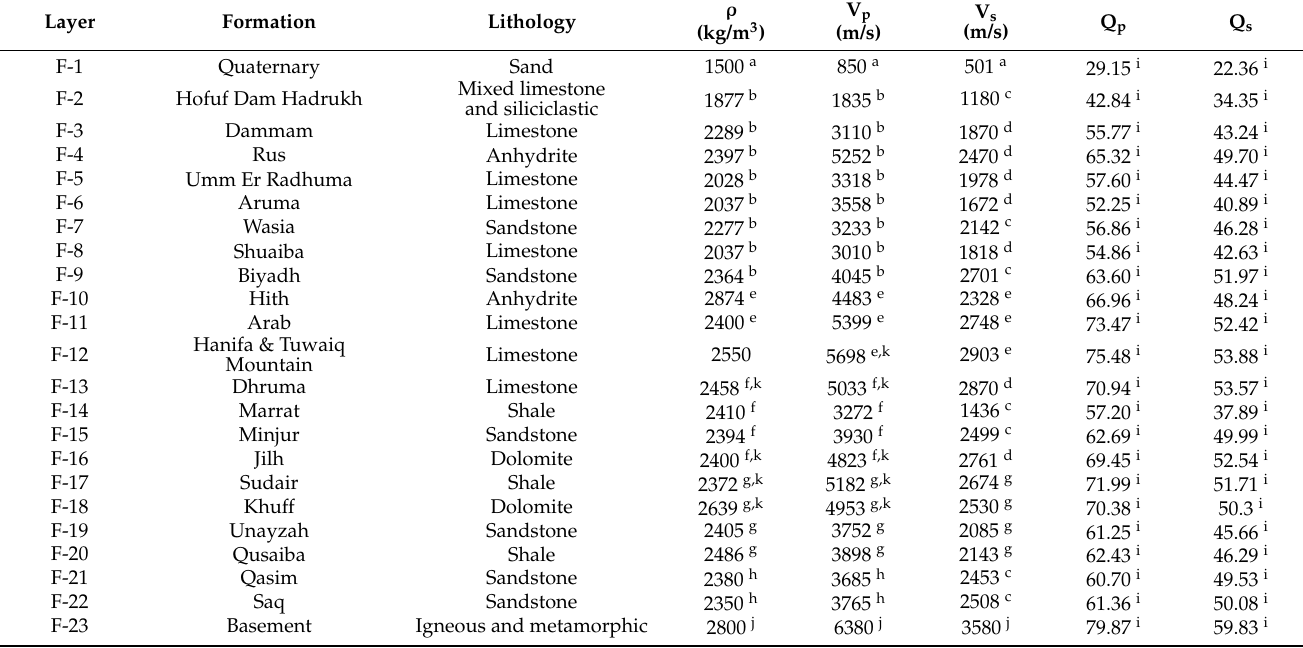
Figure 2. Digitized 2D model of the Rub’ Al-Khali basin. Solid curves indicate horizons while dotted lines indicate faults. Table 1. Lithology, densities, compressional and shear-wave speeds, compressional and shear wave quality factors of layers of the eastern Rub’ Al-Khali basin